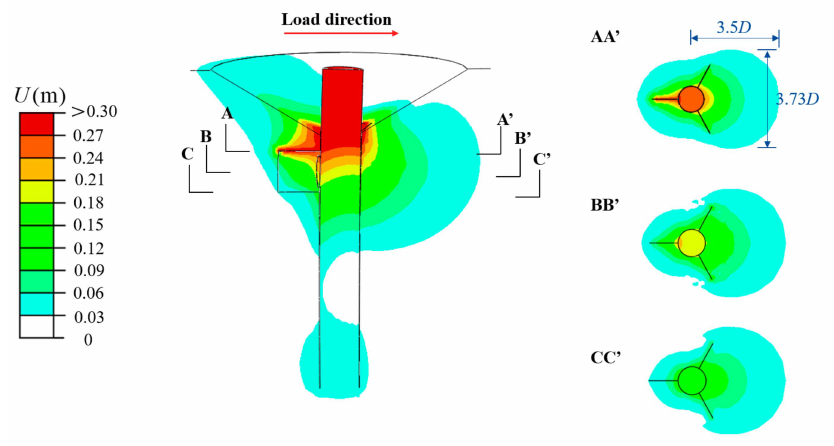
Figure 20. Sand displacement in the plane of symmetry and the planform of the three-wing monopile under scour ( S/D = 1.5) at θ = 2 ◦ .